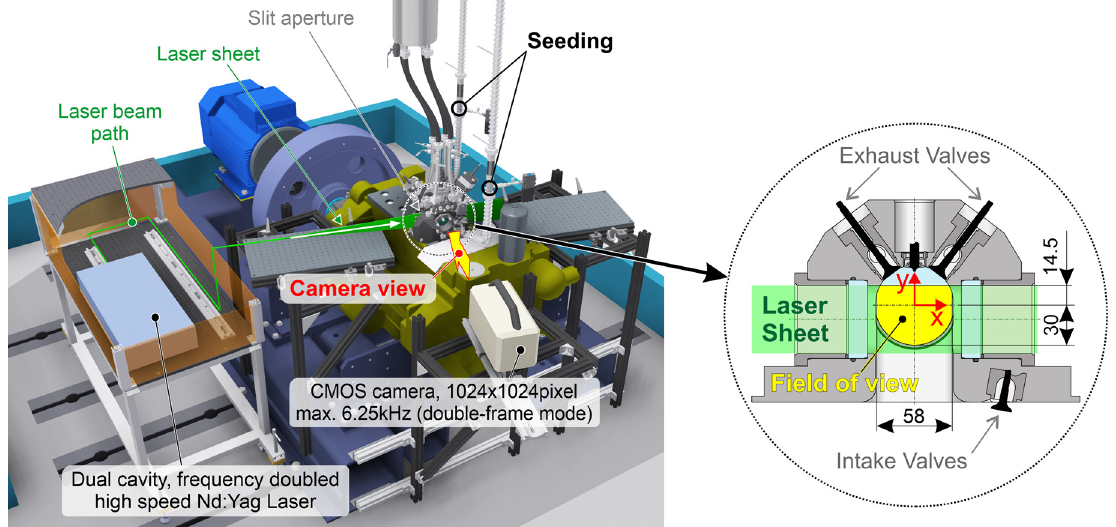
Figure 13. Optical setup for the PIV flow field measurements in the Flex-OeCoS.